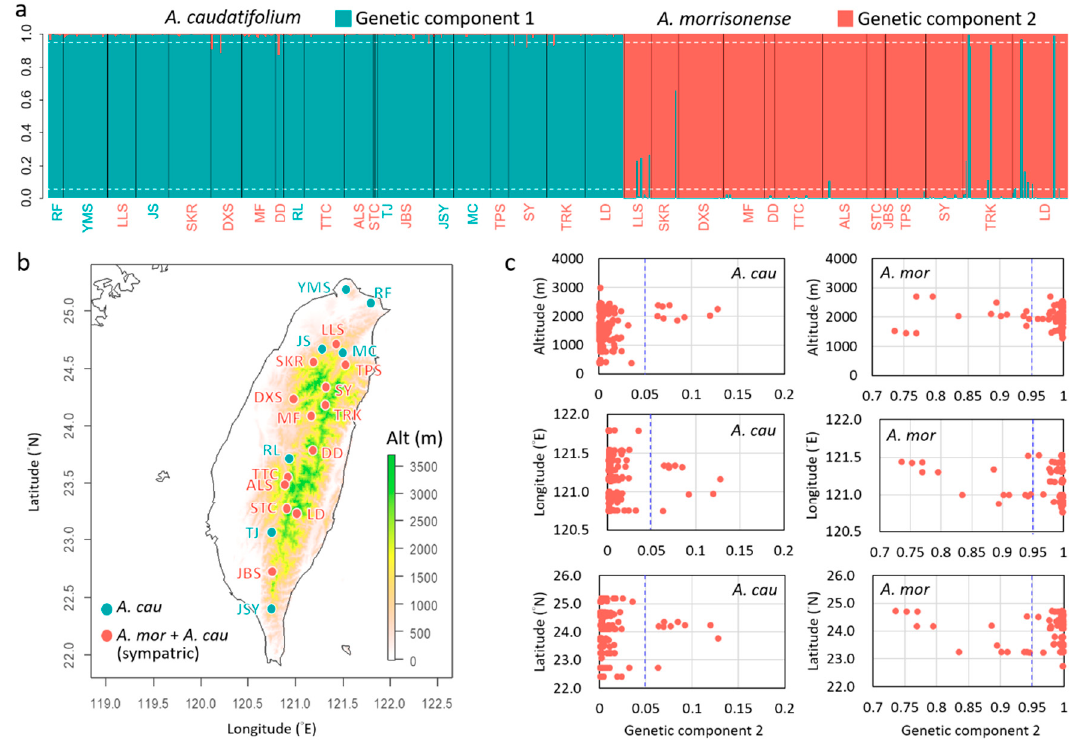
Figure 5. Genetic admixture patterns between Acer caudatifolium and A. morrisonense . ( a ) The Bayesian clustering analysis (STRUCTURE) shows the genetic admixture between species. The dotted line indicated the introgression threshold of 5% genetic components of the other species. Populations abbreviated in red indicate sympatric distribution in two species. ( b ) Geographic distribution of sampling sites. Populations denoted in red are the sympatric populations. ( c ) Altitudinal, longitudinal, and latitudinal distribution of the genetic component 2 (the red component in ( a )) in two maple species. The left panels are distributions of A. caudatifolium, and the right panels are distributions of A. morrisonense . The blue dotted line indicates the introgression threshold of 5% genetic components of the other species. The misidentified samples of A. morrisonense , i.e., >50% genetic components of A. caudatifolium , are not shown in ( c ).